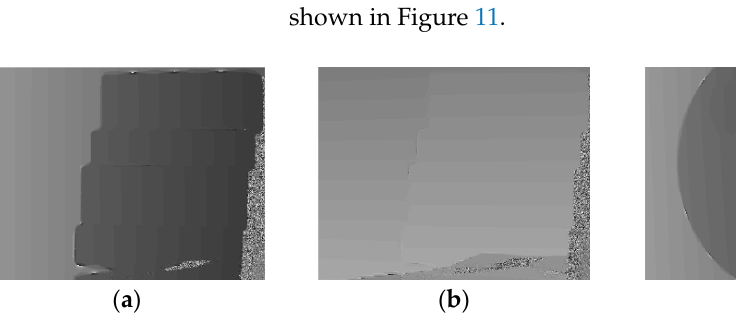
Figure 10. Absolute phase maps: ( a,b ) rectangular step; ( c , d ) circular step gauge.